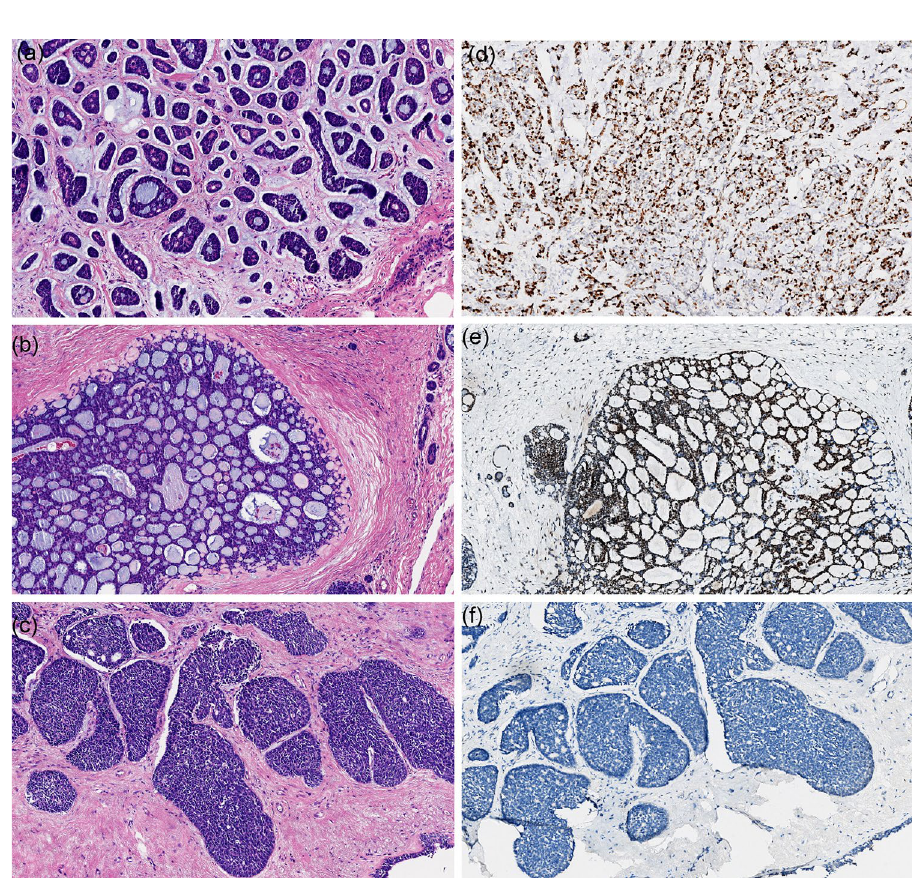
Figure 2. Morphological Features of Classic and Solid-basaloid Breast AdCCs. ( a – c ) exhibit three histological characteristics of hematoxylin and eosin (H&E) images in AdCC; ( a ) AdCC with cribriform and tubular growth; ( b ) conventional cribriform growth with accumulation of basal membrane material in pseudoluminae; ( c ) showing solid-basaloid growth pattern; ( d ) presents a high Ki-67 index of immunostaining; ( e , f ) represent micrographs of MYB expression (strong and diffuse positive and negative,